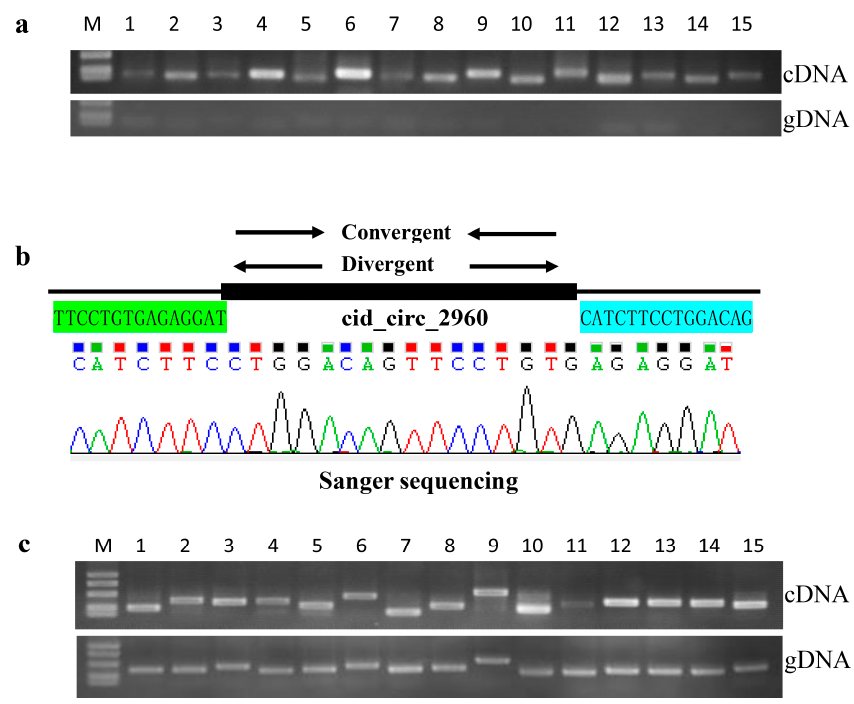
Figure 7. Confirmation of circRNAs by PCR and Sanger sequencing. ( a ) Amplification of circRNAs using divergent primers with cDNA and genomic DNA (gDNA) templates. circRNA forms were only amplified from cDNA samples. M: DNA molecular markers. The sizes of the three bands are 500, 250, and 100 bp (from top to bottom); ( b ) Sanger sequencing confirmation of the head-to-tail backsplicing of circRNA cid_circ_2960. The highlighted (green and blue) nucleotides indicated the junction sequences of circRNA cid_circ_2960; ( c ) Amplification of circRNAs using convergent primers with cDNA and genomic gDNA templates. Convergent primers could amplify the expected bands from both cDNA and genomic DNA samples. M: DNA molecular markers. The sizes of the five bands are 1000, 750, 500, 250, and 100 bp (from top to bottom). Numbers 1–15 refer to cid_circ_0069, cid_circ_0547, cid_circ_1653, cid_circ_3555, cid_circ_4537, cid_circ_3204, cid_circ_1816, cid_circ_2796, cid_circ_3277, cid_circ_4726, cid_circ_0443, cid_circ_1569, cid_circ_2061, cid_circ_2287, and